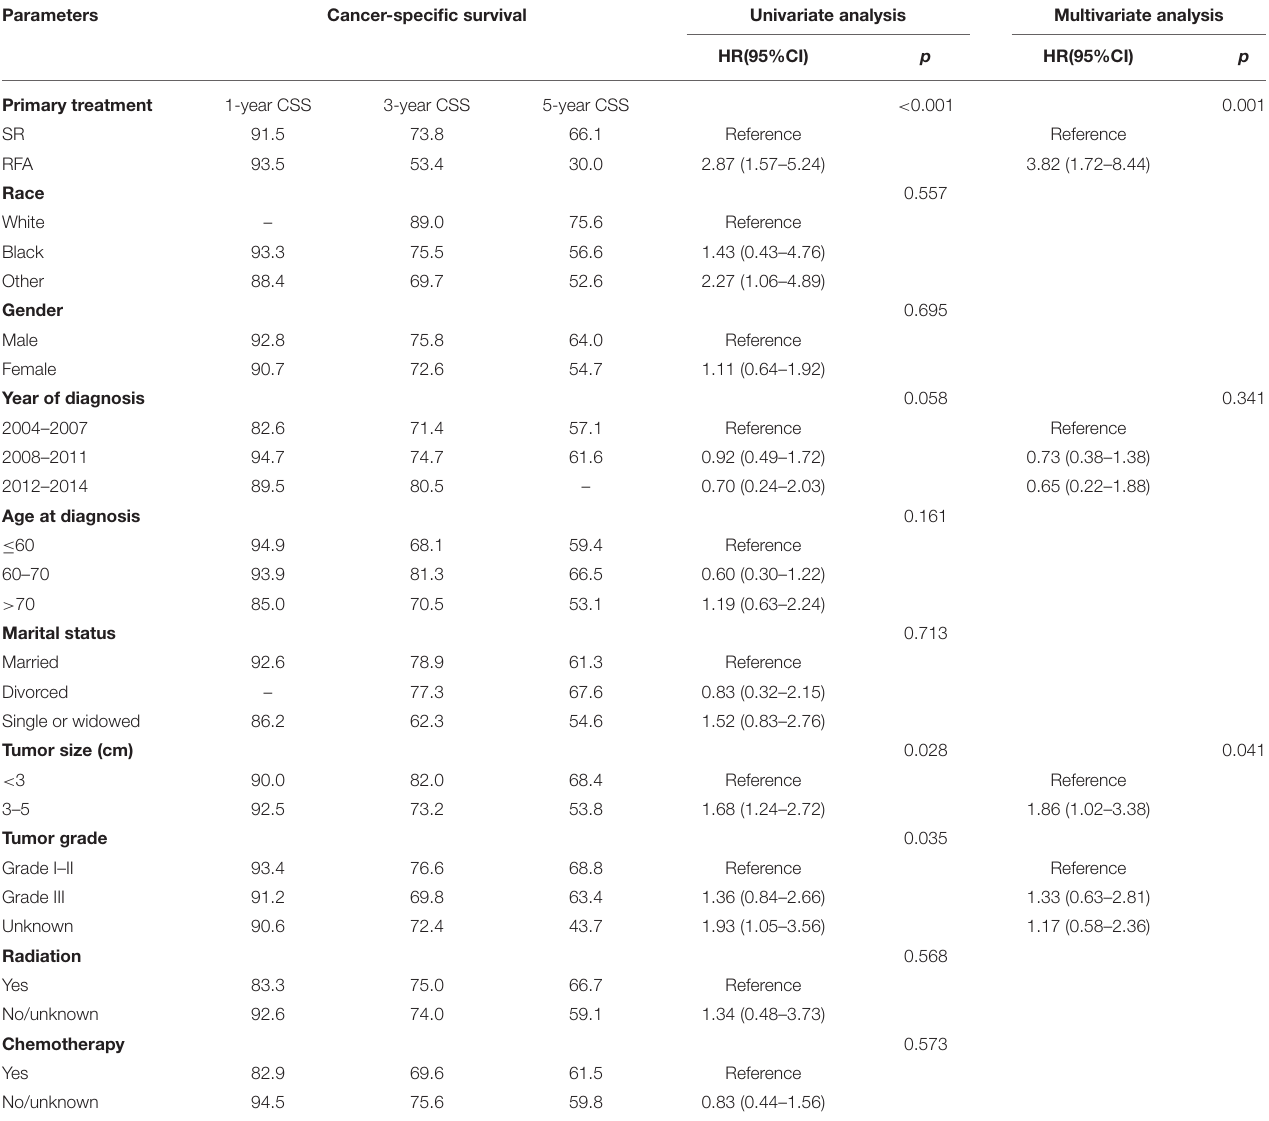
TABLE 3 | Survival analysis in terms of cancer-specific survival.